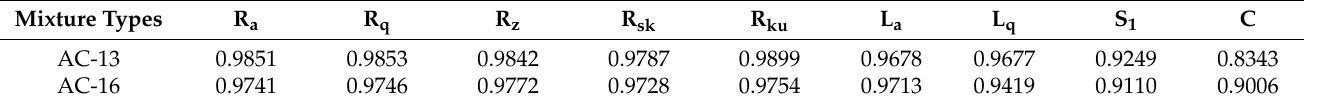
Table 5. Grey entropy correlation degree of different mixtures between different macro-texture indexes and F 60